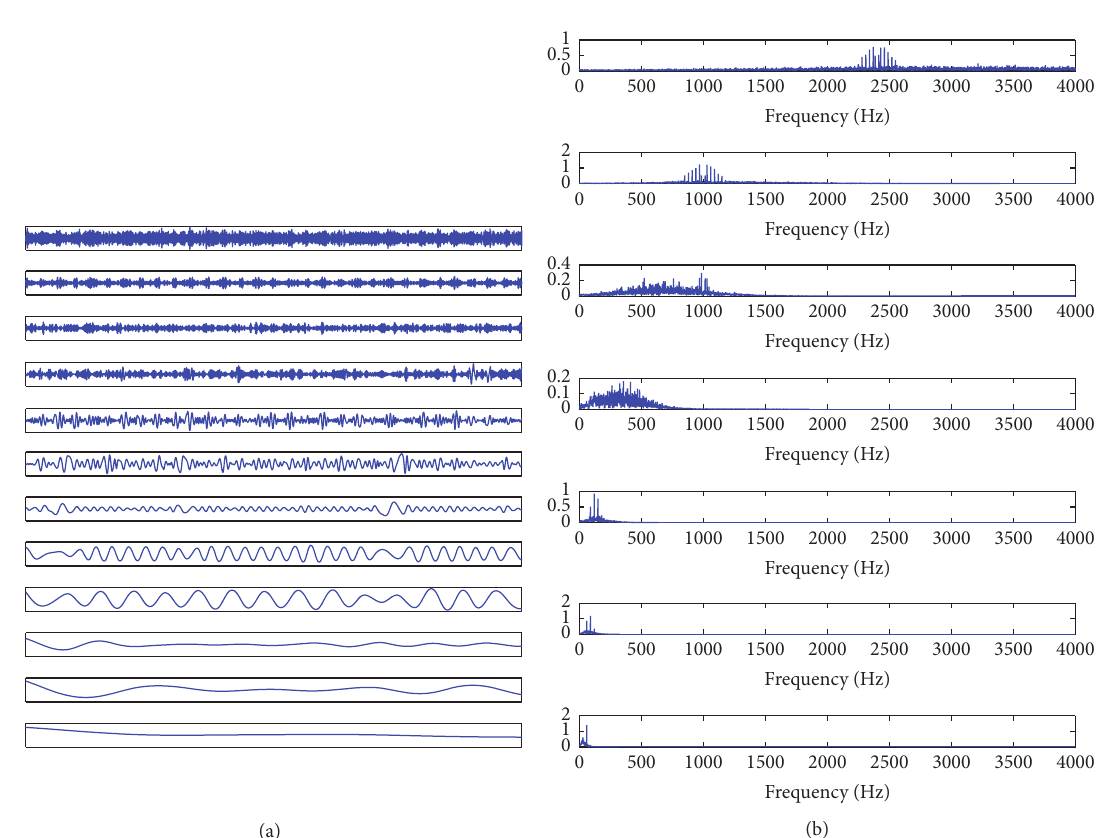
Figure 3: EMD subsignals (IMFs) (a) and frequency spectrums (b) of the first 7 IMFs of the simulation